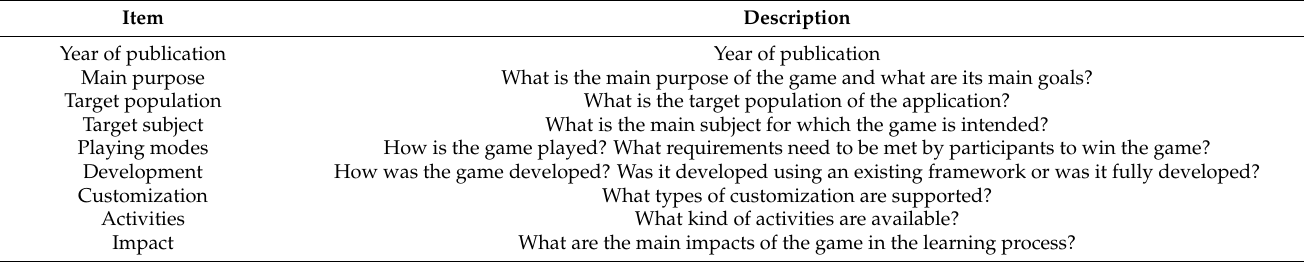
Table 2. Type of data to be